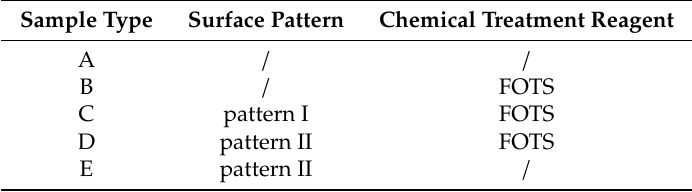
Figure 1. ( a ) Han’s Laser marking machine; and pattern design schematics of ( b ) parallel microgrooves (pattern I) and ( c ) spot arrays (pattern II) fabricated by laser surface texturing. Table 1. Sample type, surface pattern, and chemical treatment reagent used for different samples fabricated in this work.